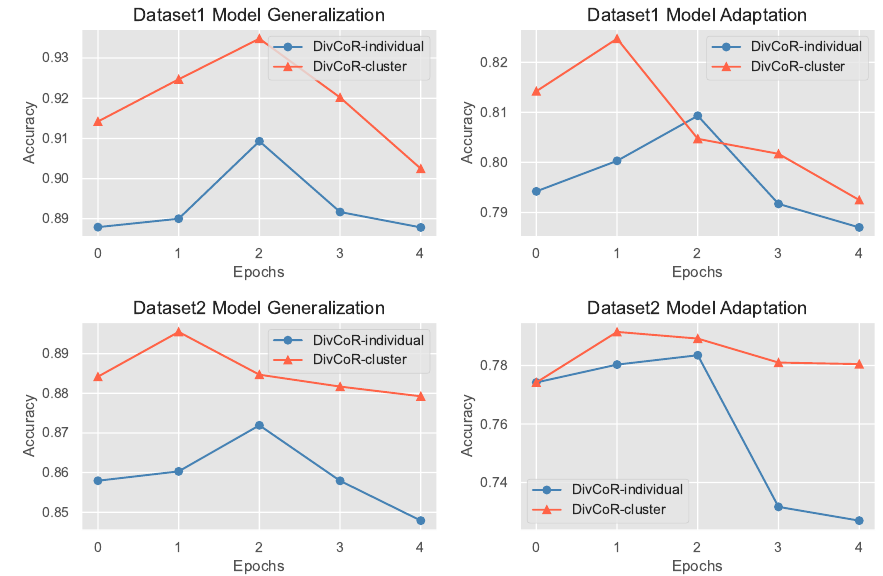
Figure 9. Evaluation on local train